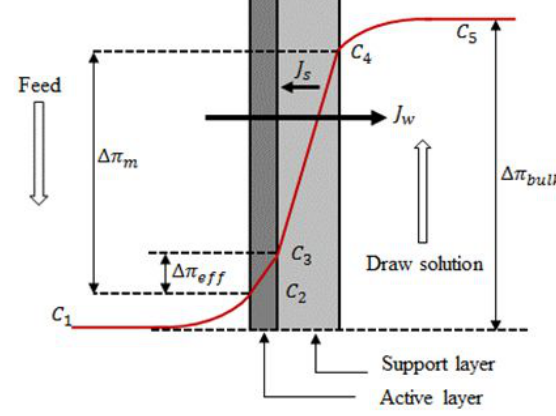
pressure force in FO mode.